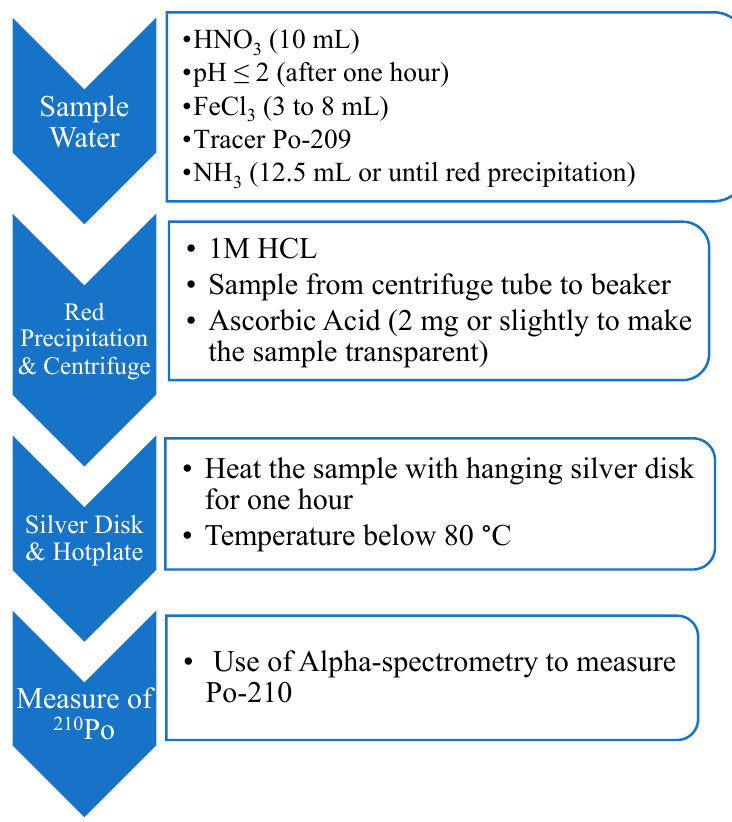
Figure 2. Steps of chemical analysis of Po-210 for fresh water sample [38].